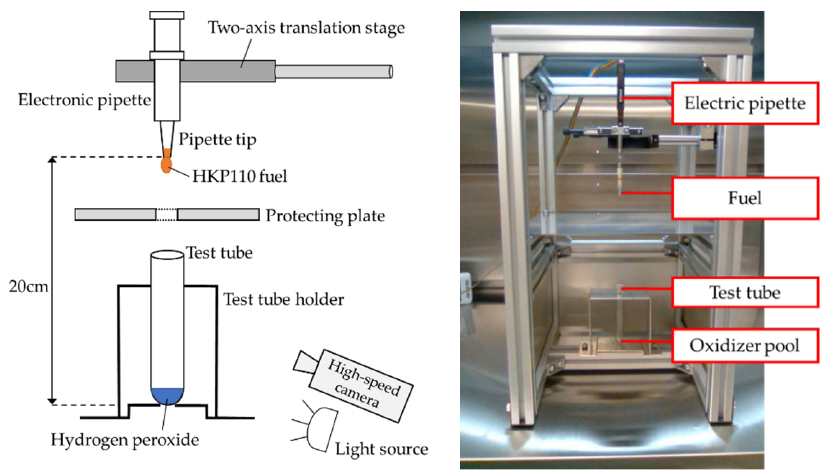
Figure 3. Single ‐ drop test apparatus (left: diagram, right: external view). Figure 3. Single-drop test apparatus (left: diagram, right: external view).